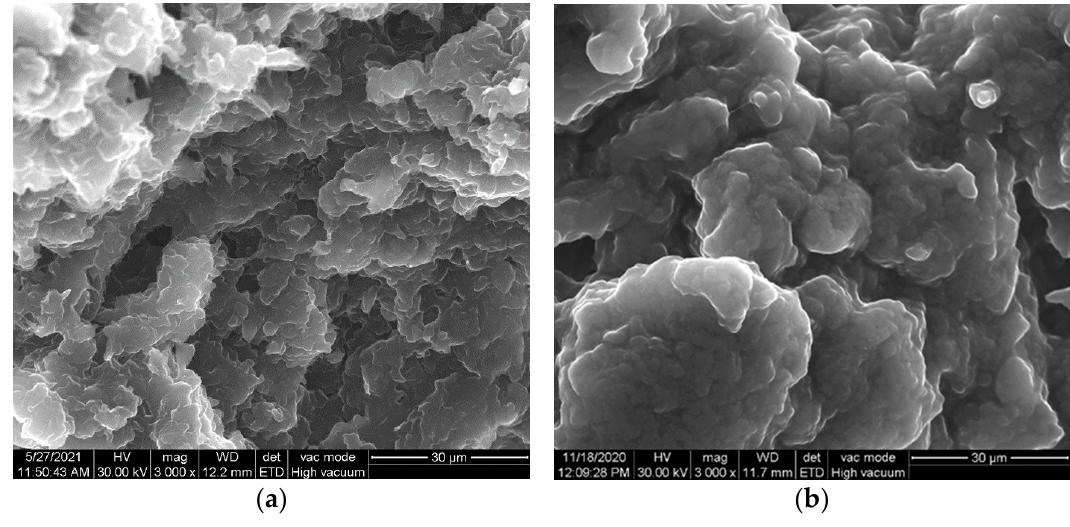
Figure 1. SEM images of paraffin oil-based carbon paste: ( a ) CNT and ( b ) GR-CNT. The electroactive electrode areas were calculated by comparing the apparent diffu- sion coefficient value determined by classical method with the theoretical diffusion coef- ficient value of 6.70·10 − 6 cm 2 ·s − 1 reported in the literature data [41], and the results are pre- sented in Table 2. The electroactive surface areas determined for both CNT and GR-CNT paste electrodes were higher in comparison with the geometrical ones; GR-CNT exhibited the best electroactive area because the content of carbon was higher and the specific sur- face area was higher for GR than for CNT [42]. Table 2. Electroactive surface areas in comparison with geometrical ones. Electrode